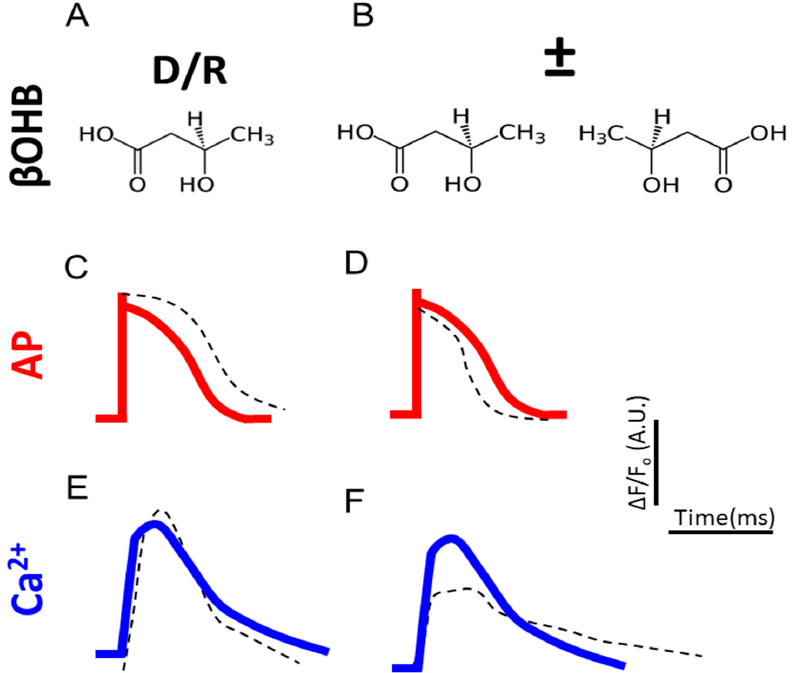
Figure 8. Summary of experimental findings. ( A , B ) Structural formulas for R β OHB and ± β OHB. ( C , D ) Quantification of FluoVolt optical AP amplitudes and durations of R β OHB and ± β OHB. ( E , F ) Quantification of Fluo4 Ca 2+ amplitudes and kinetics of R β OHB and ± β OHB. The red and blue lines represent controls.